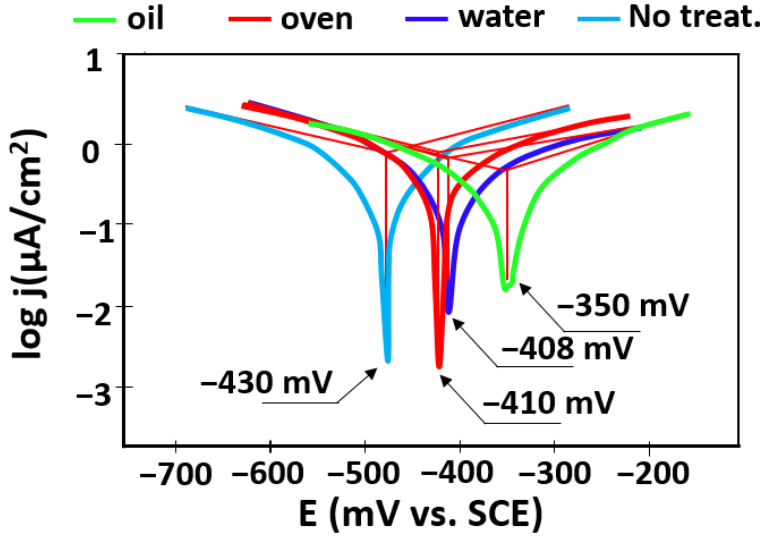
Figure 8. SEM microstructure of fractured surfaces of quenched samples in: oven ( a , b ), water ( c , d ), oil ( e , f ), and without thermal treatment ( g , h ) .